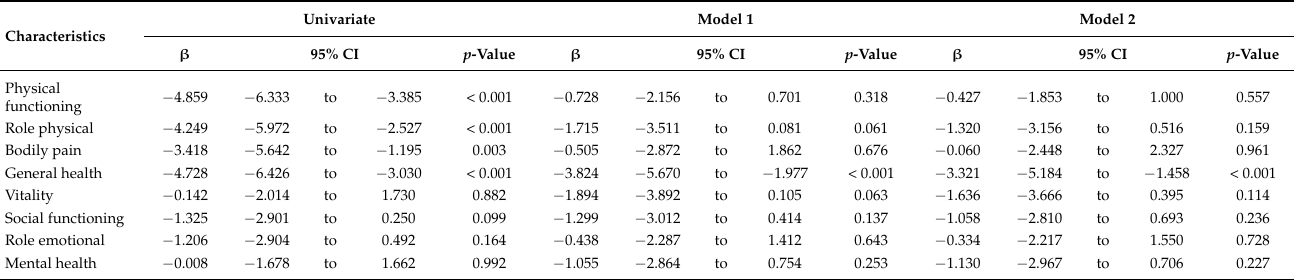
Table 4. Correlation between SF-36 scores and HbA1c levels (%).